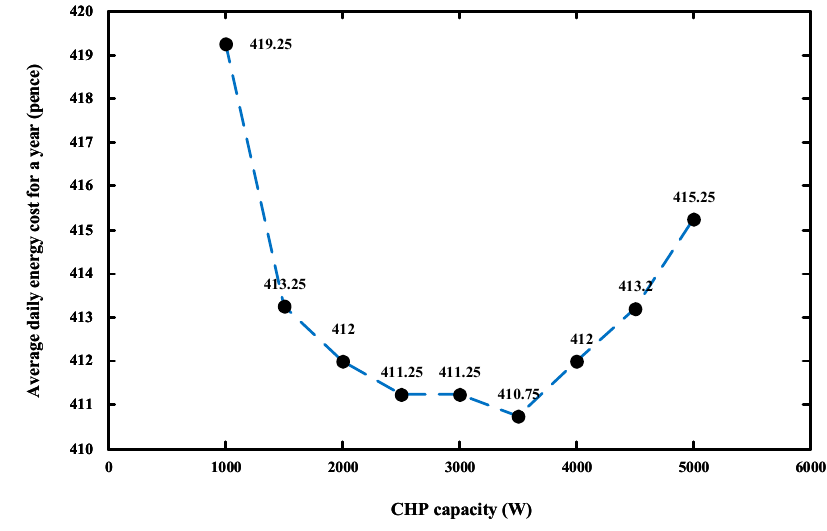
Figure 13. Average daily energy costs of a terraced house for installing different capacities gas engine CHP.